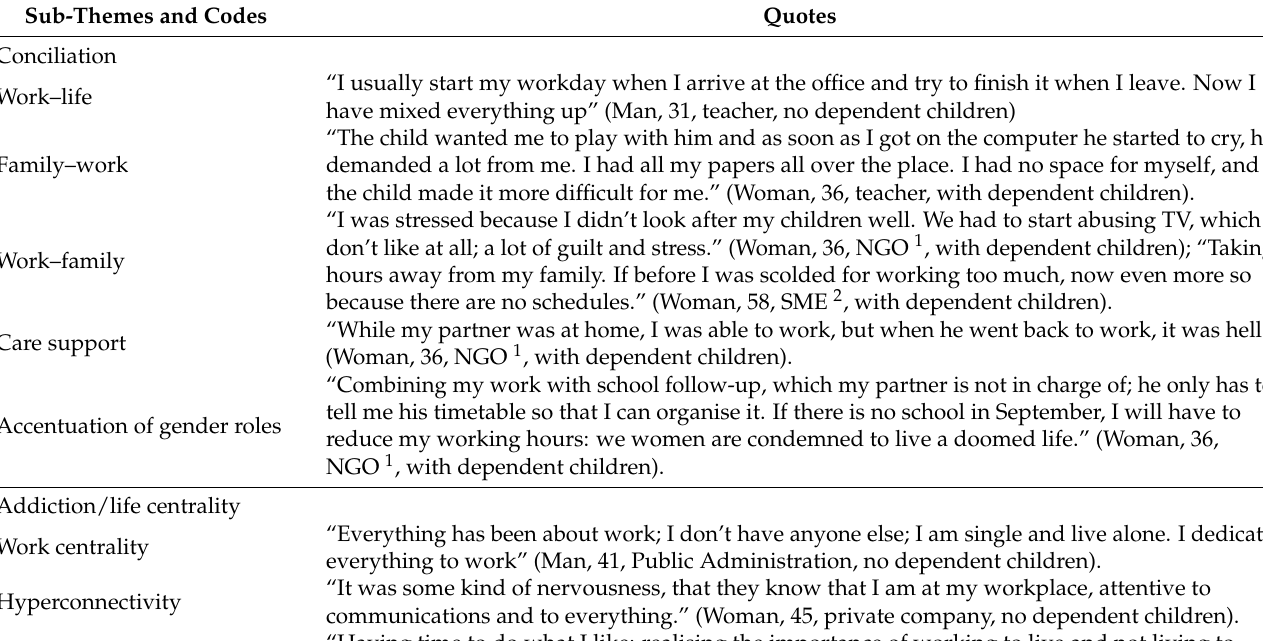
Table 3. Theme 3 developed from thematic analysis in Study 1: “work–life balance management and centrality of life in the lockdown context”.